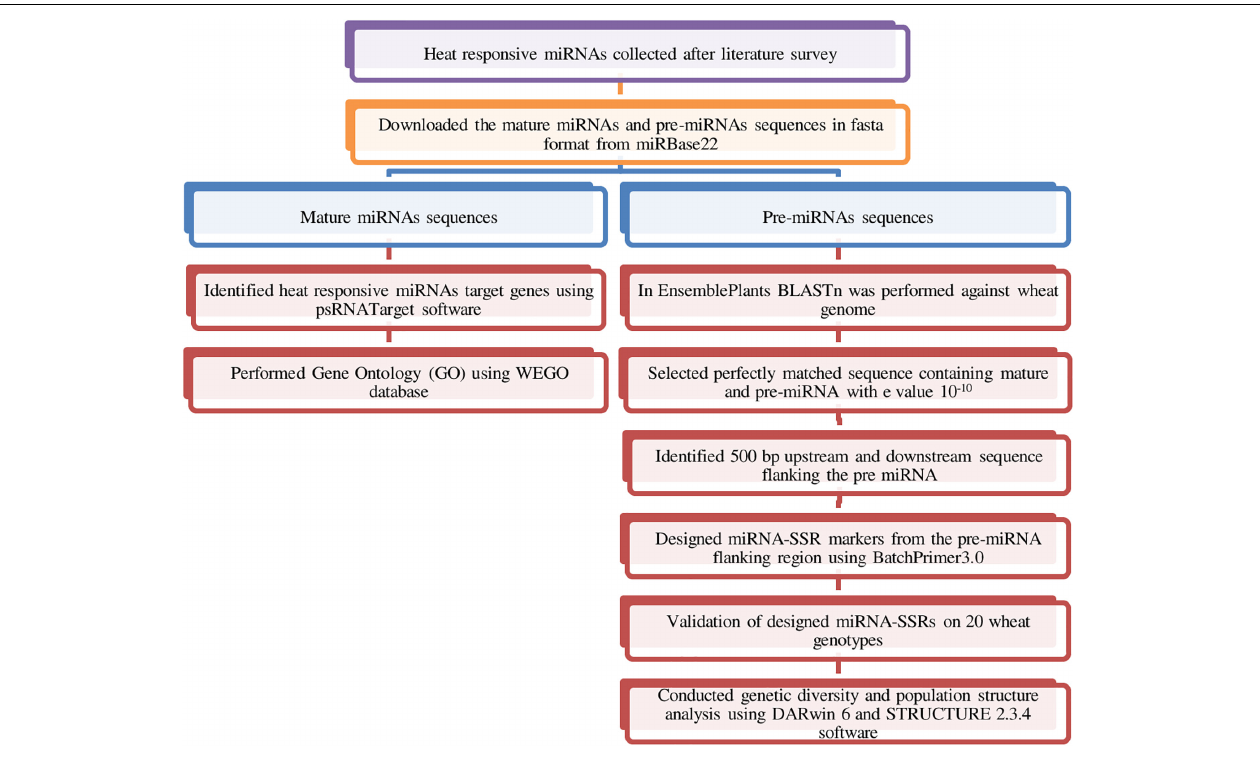
FIGURE 1 | Pipeline describing the process of identification and validation of miRNA-SSRs in